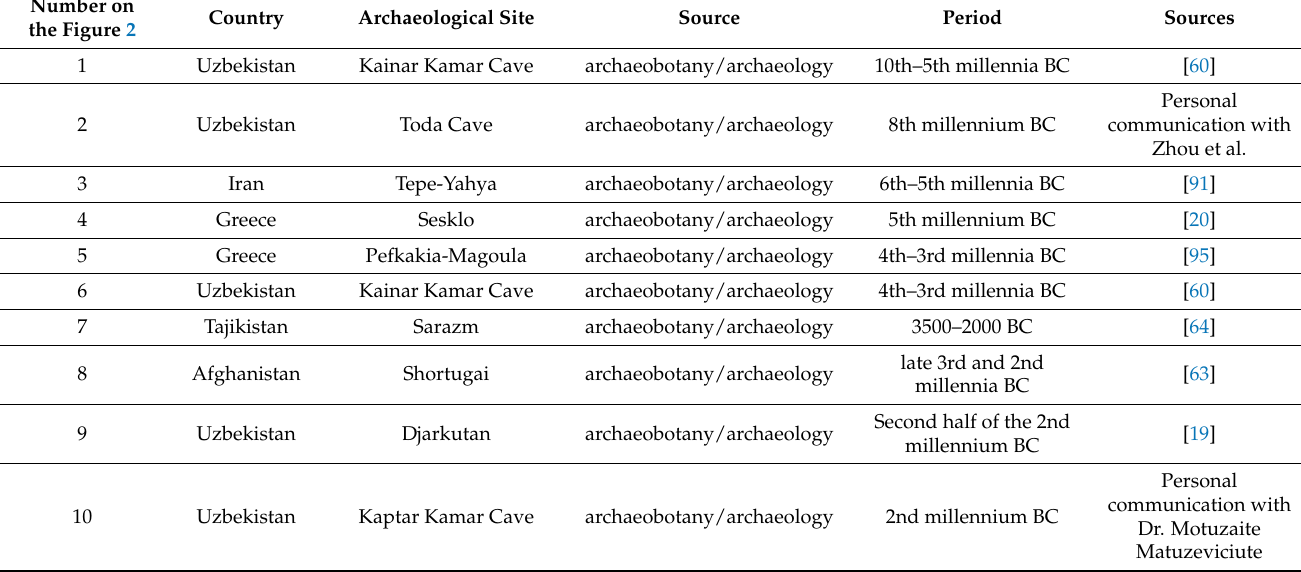
Table 1. P. vera remains mentioned in archaeobotanical, archaeological, and historic written